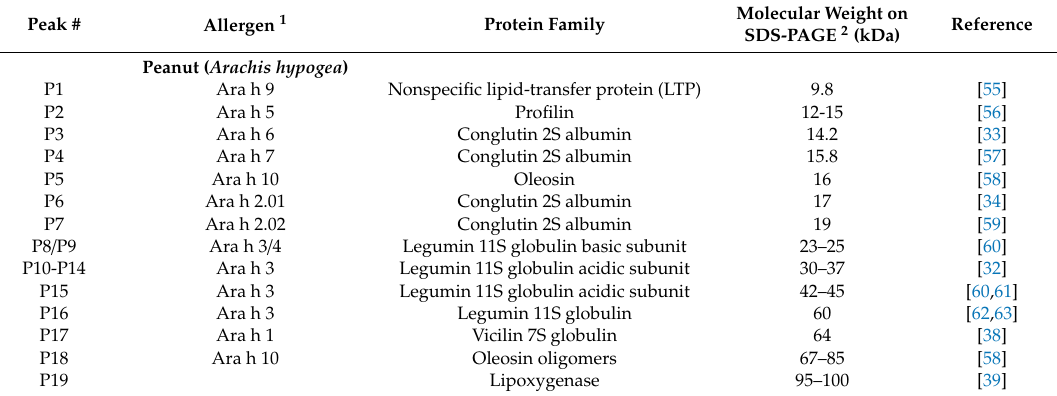
Table 2. Potential correspondence of resolved peanut, almond, hazelnut and pistachio proteins to known